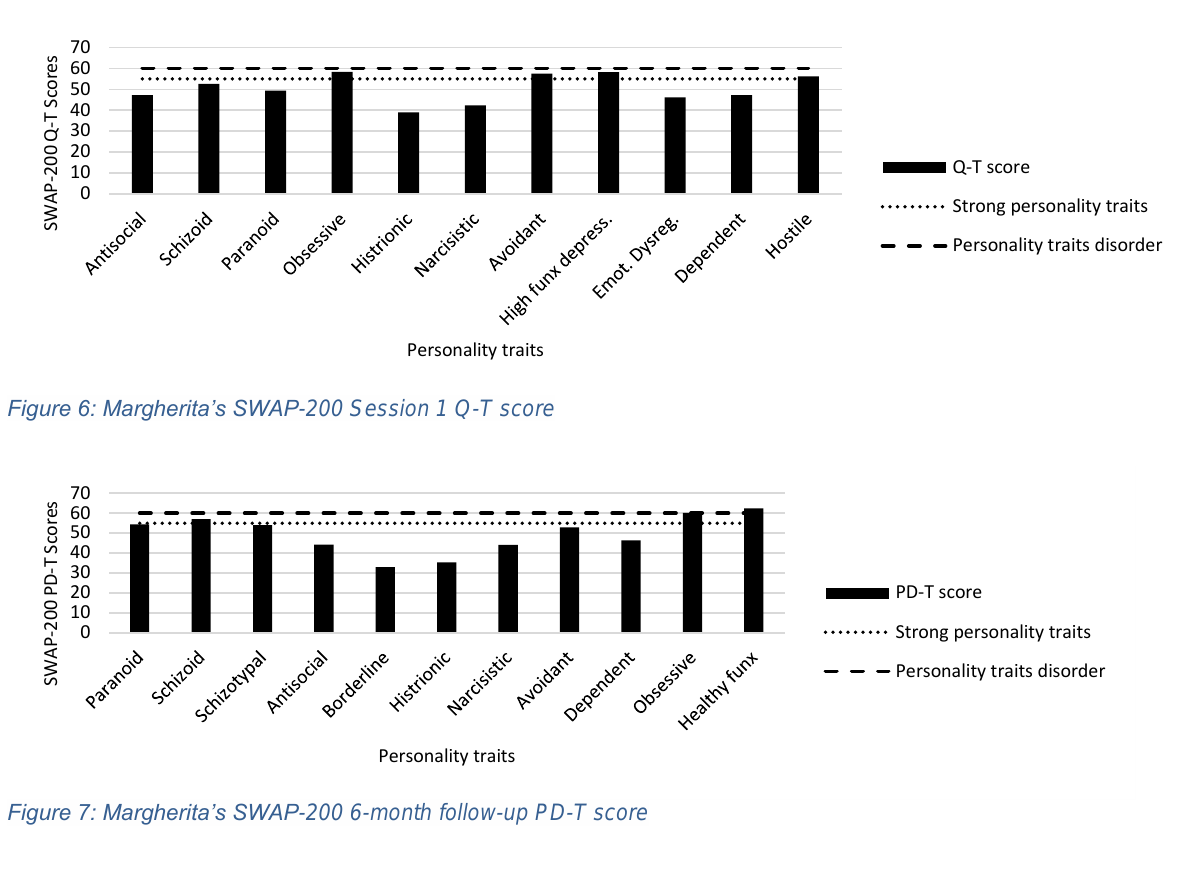
Figure 5: Margherita’s SWAP-200 Session 1 PD-T score